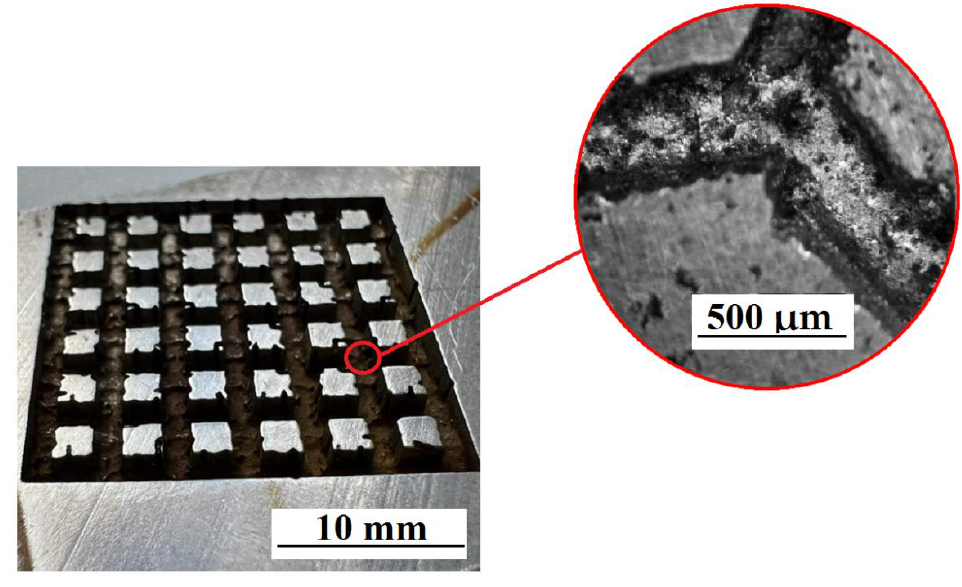
Figure 8. ET with a square section.